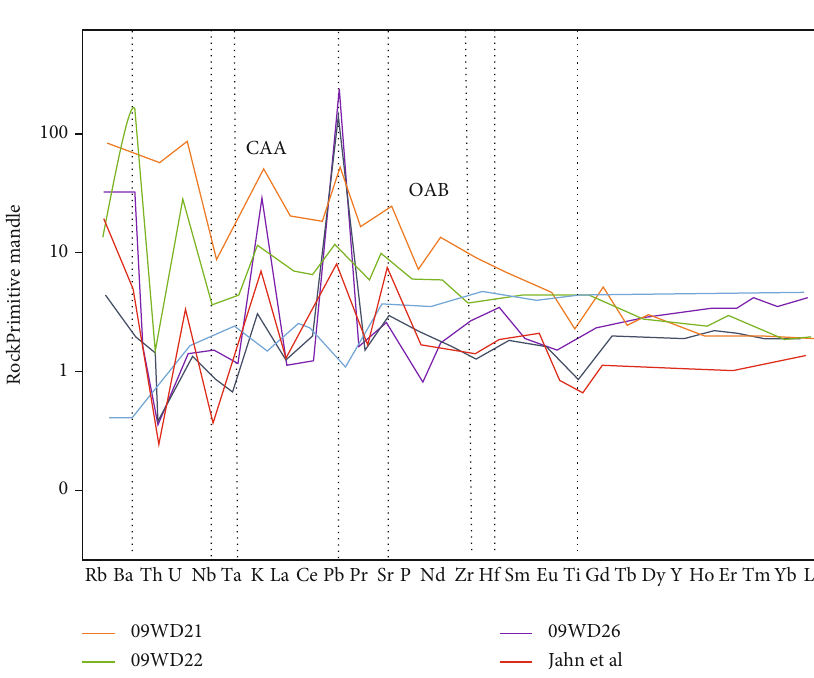
Figure 1: Diagram of the main element silico-alkali.